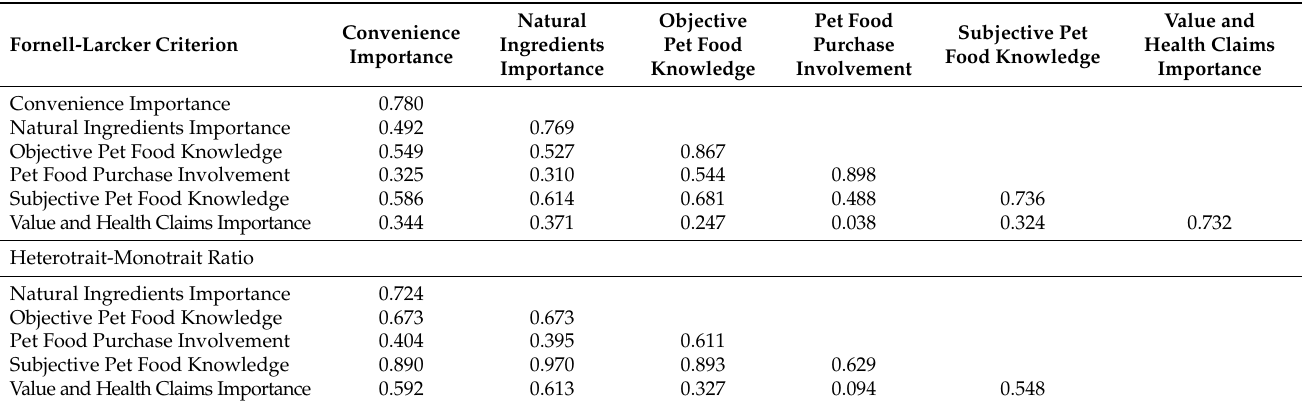
Table 3. Fornell-Larcker and Heterotrait-Monotrait Discriminant Validity Test Results. Fornell-Larcker